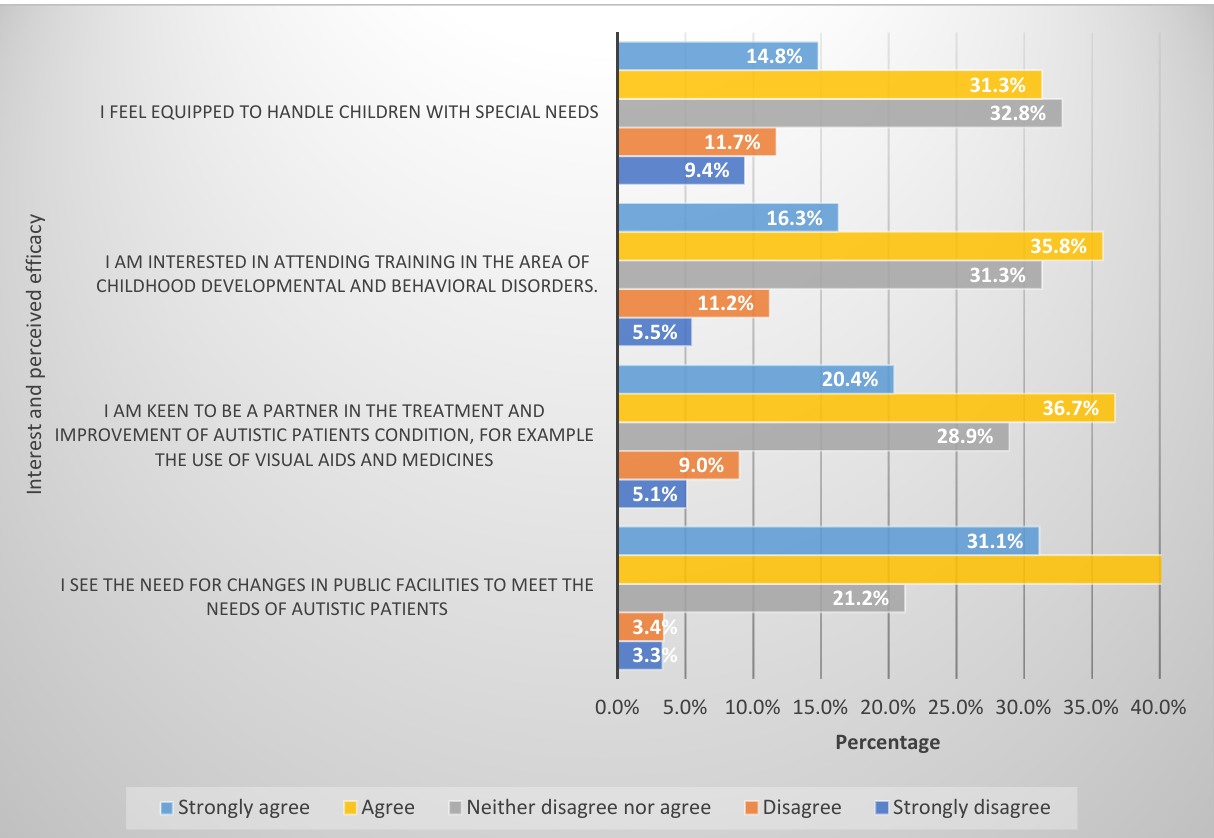
Figure 3. Participants’ interest and perceived efficacy towards autism management.